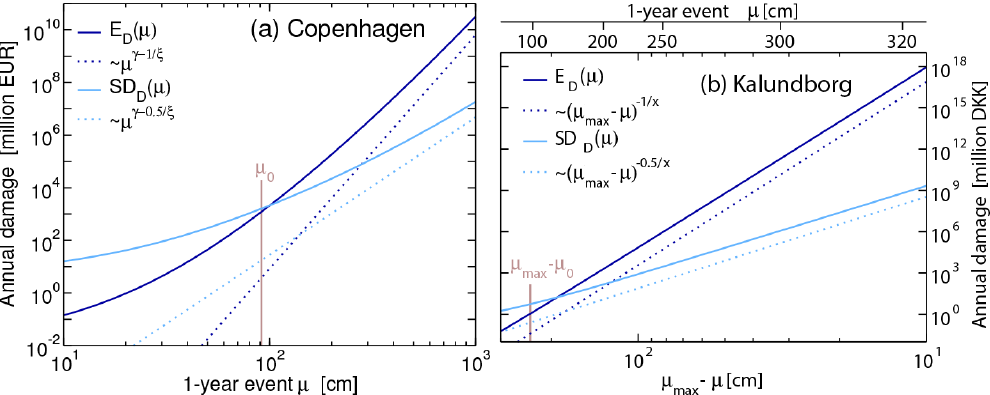
Figure 4. Expected annual damage (dark blue) and standard deviations (light blue) in (a) Copenhagen and (b) Kalundborg as a function of the mean sea level (parametrised by the 1-year flood µ ). The dotted lines show the asymptotic relations Eqs. (12), (13) and (14) with γ = 1 . 6 and ξ = − 0 . 14 (Copenhagen) and γ = 4 . 1 and ξ = 0 . 08 (Kalundborg). The values for the current 1-year floods µ 0 = 91 . 21cm (Copenhagen) and µ 0 = 95 . 35cm (Kalundborg) are indicated by brown vertical lines. The abscissa in the right panel is inverted and shows the difference between the 1-year flood µ and µ max = 332 . 04cm (at the top, the corresponding 1-year floods are